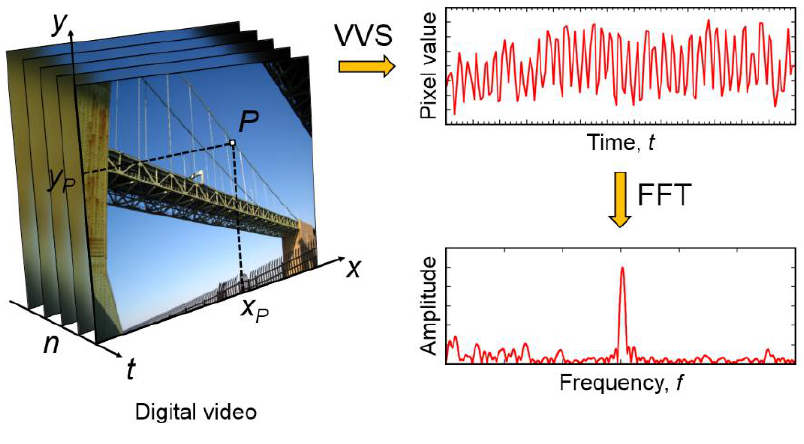
Figure 1. Proposed methodology of a virtual visual sensor (VVS) to measure structural vibrations. x and y represent fixed coordinates of the monitored pixel, P p p